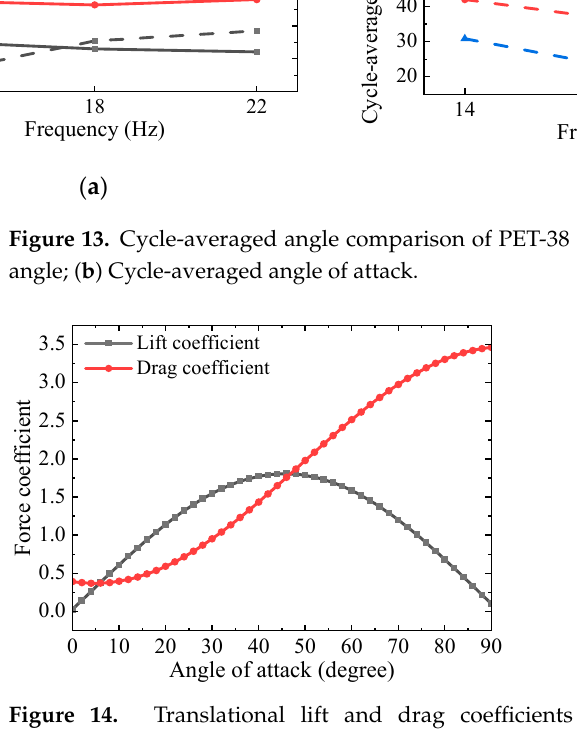
Figure 13. Cycle-averaged angle comparison of PET-38 and TPU-30. ( a ) Cycle-averaged rotation angle; ( b ) Cycle-averaged angle of attack.